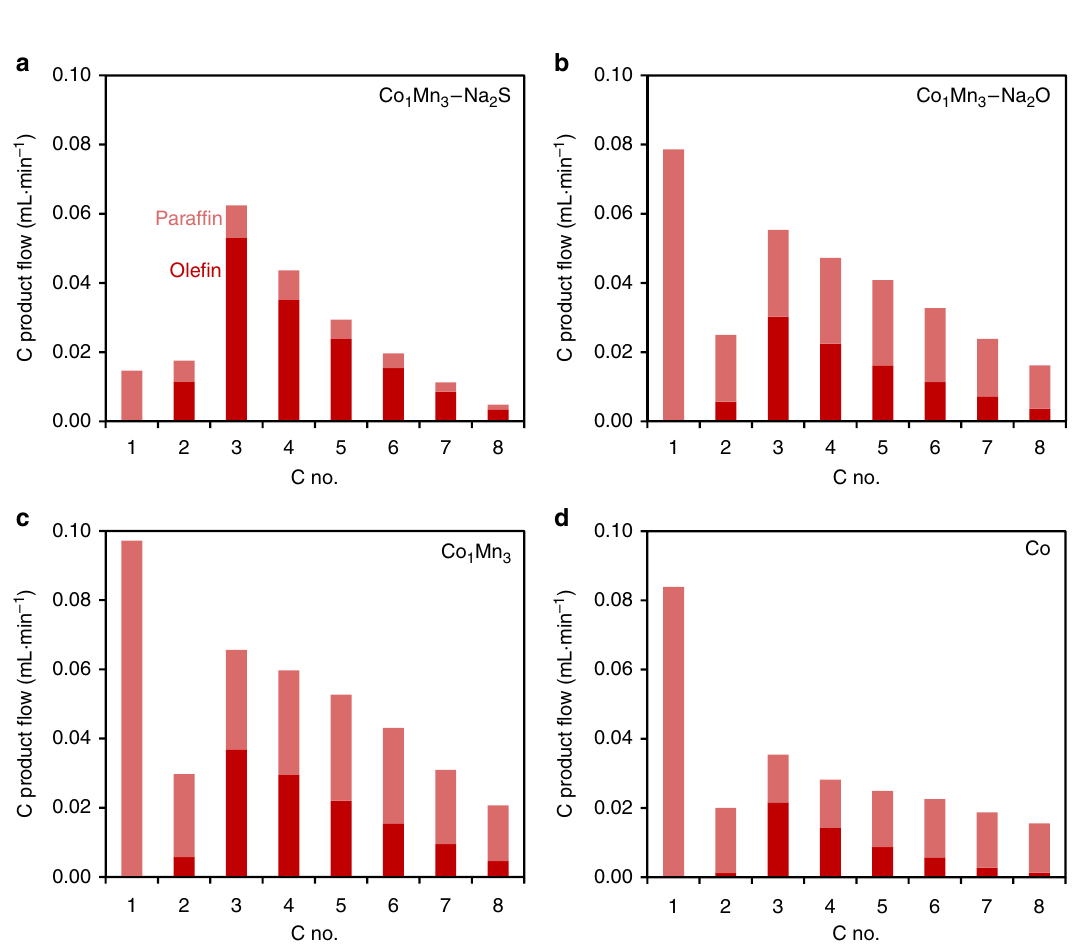
Fig. 3 Distribution of 1-ole fi ns and n -paraf fi ns of C 1 – C 8 hydrocarbon products. Reaction conditions: 240 °C, 10 bar, H 2 /CO = 2, 18 – 30% CO conversion. a Co 1 Mn 3 – Na 2 S, b Co 1 Mn 3 – Na 2 O, c Co 1 Mn 3 and d Co. Red bar corresponds to ole fi n product fl ow and light red bar corresponds to paraf fi n product fl ow